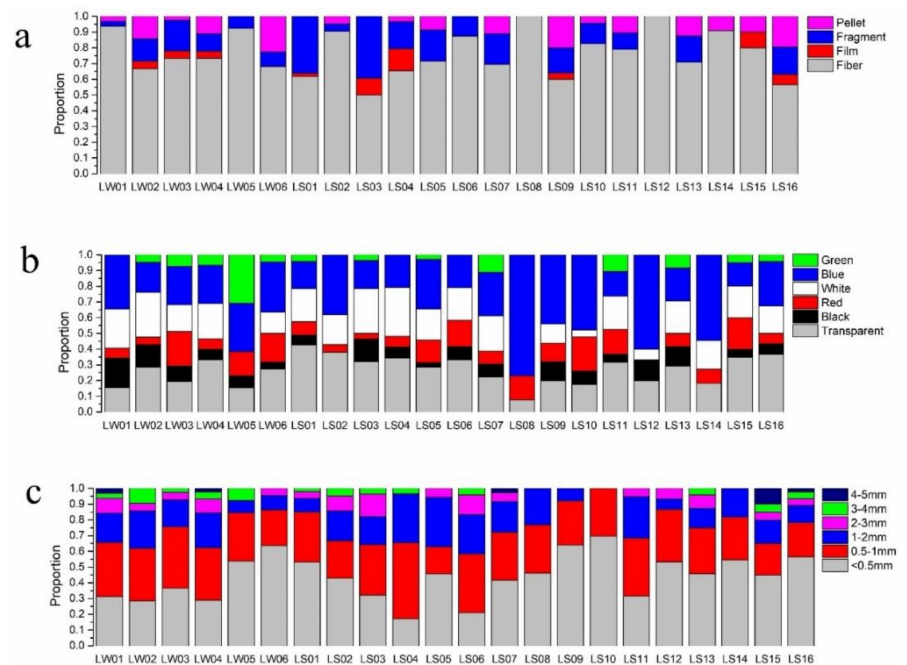
Figure 4. Proportion of ( a ) shape distribution ( b ) color distribution and ( c ) size distribution of microplastics in lake center sites.